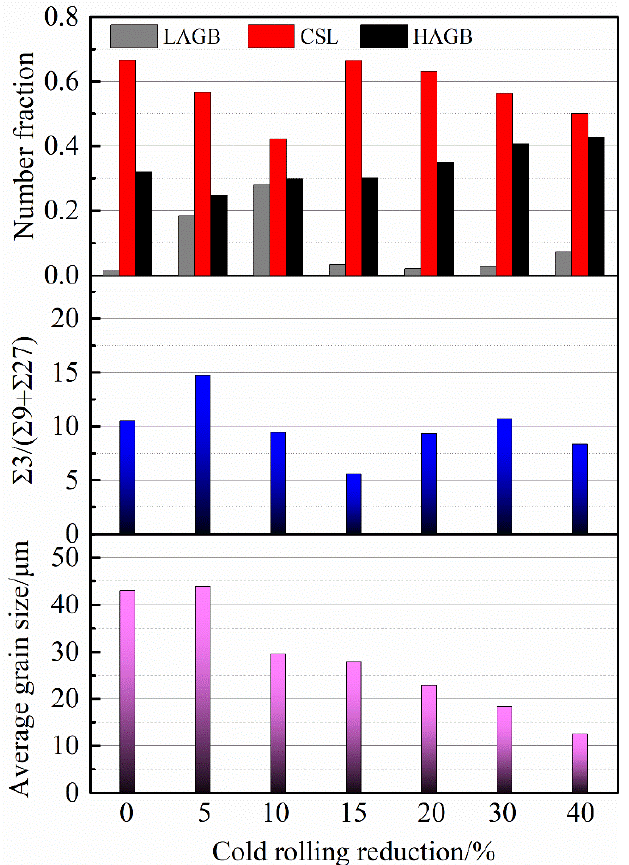
Figure 6. Cold rolling reduction dependent of GBCD, ratio of Σ 3/ Σ 9 + Σ 27 and grain size of C276 superalloy after annealing at 1050 ◦ C for 30 min. (“0” denotes the initial sample without cold rolling and